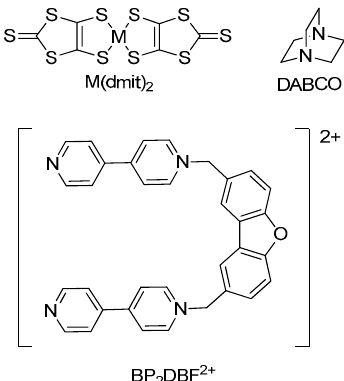
Figure 1. Molecular structures of abbreviated chemical species. dmit 2 − = 1,3-dithiole-2-thione-4,5-dithiolate; DABCO, 1,4-diazabicyclo[2.2.2]octane; BP 2 DBF 2+ = dibenzofuran-2,2 ′ -bis( N -methylene-4,4 ′ -bipyridinium).